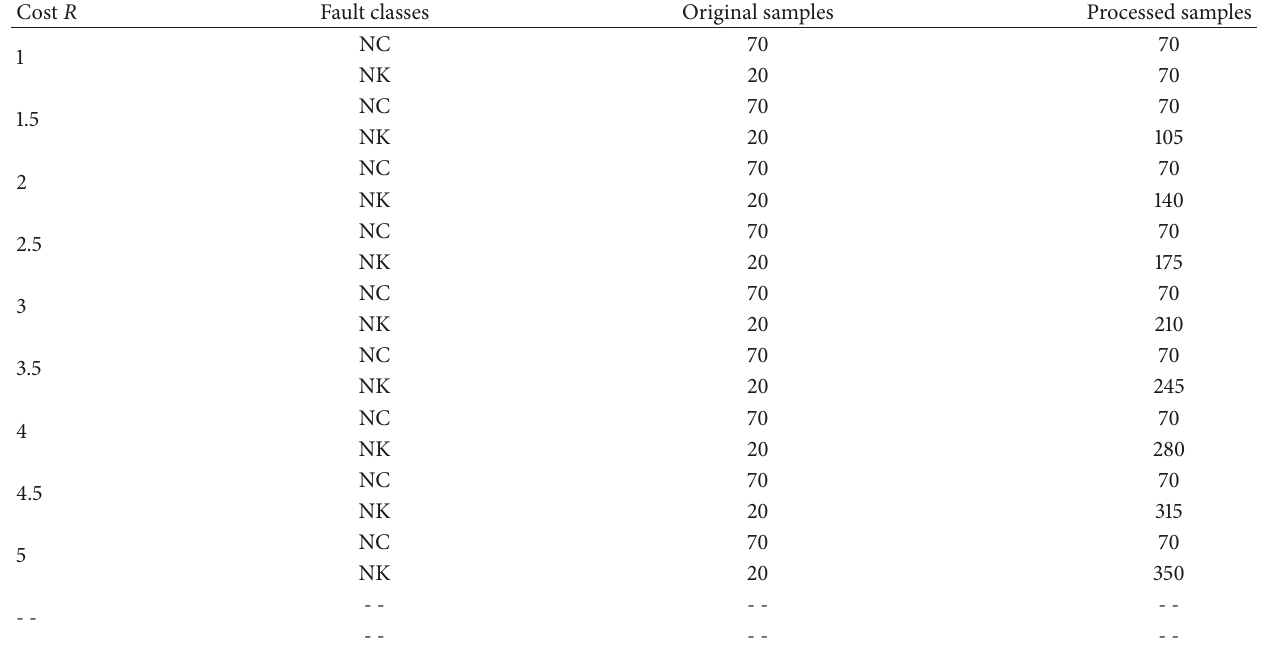
Table 5: The data sample distribution by oversampling for check